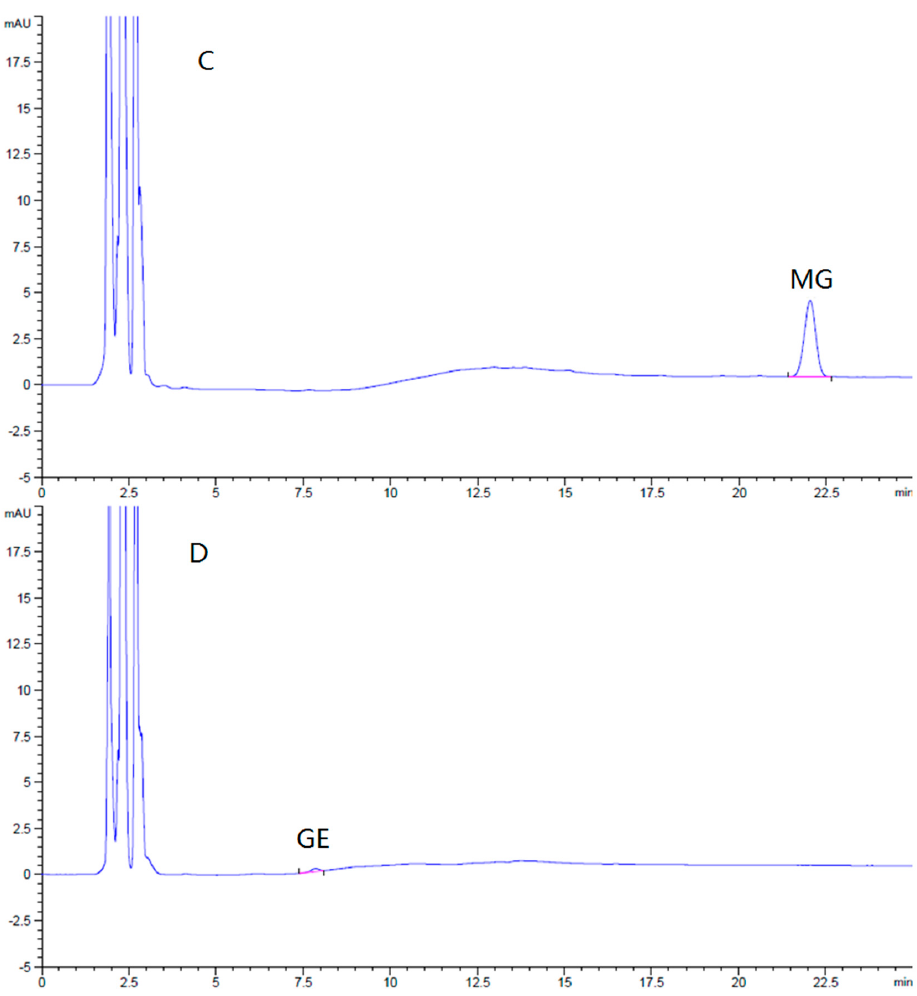
Figure 7. ( A ) Typical HPLC chromatograms of blank brain homogenate of mice, ( B ) blank brain homogenate of mice spiked with GE and MG; and brain homogenate sample of mice after oral administration with ( C ) MG or ( D ) GE.